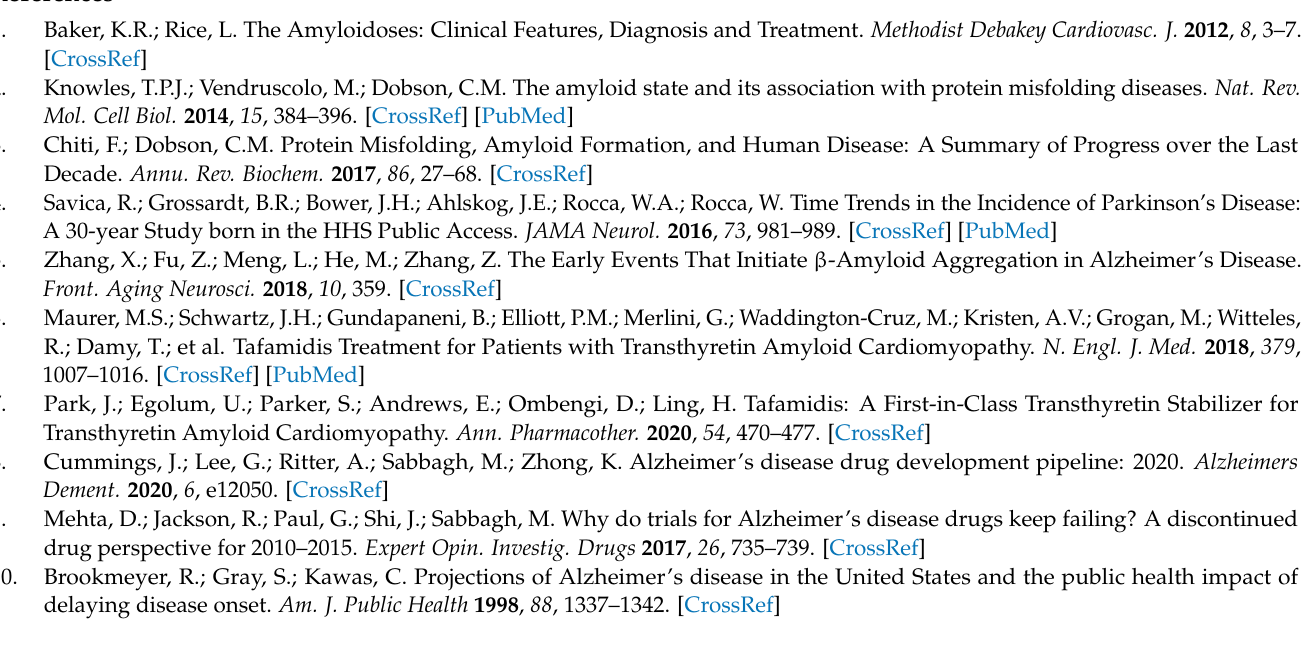
Figure A3. Lag time ( A ) and elongation rate ( B ) of all eight fibril types under identical ionic strength (500 mM NaCl), non-aggregated α -syn (50 µM) and initial fibril concentration (2.5 µM). Lag time and elongation rate values were calculated as shown in Figure A2.